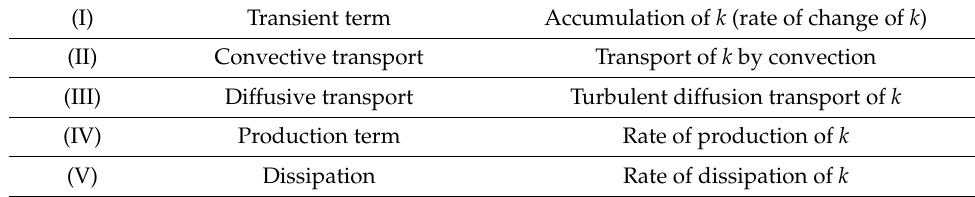
Table 1. Description of the terms used in Equation (6)